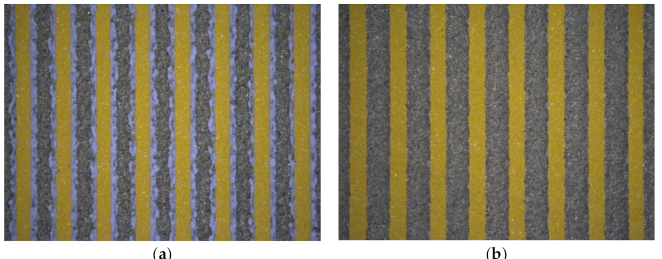
Figure 8. Analysis of the influence of graphite layer on electrode shape and surface quality, in dependence of printing sequence: ( a ) dielectric layer (blue) printed in between of graphite strips (SS-GD); ( b ) graphite layer (gray) printed after the dielectric layer (SS-DG).